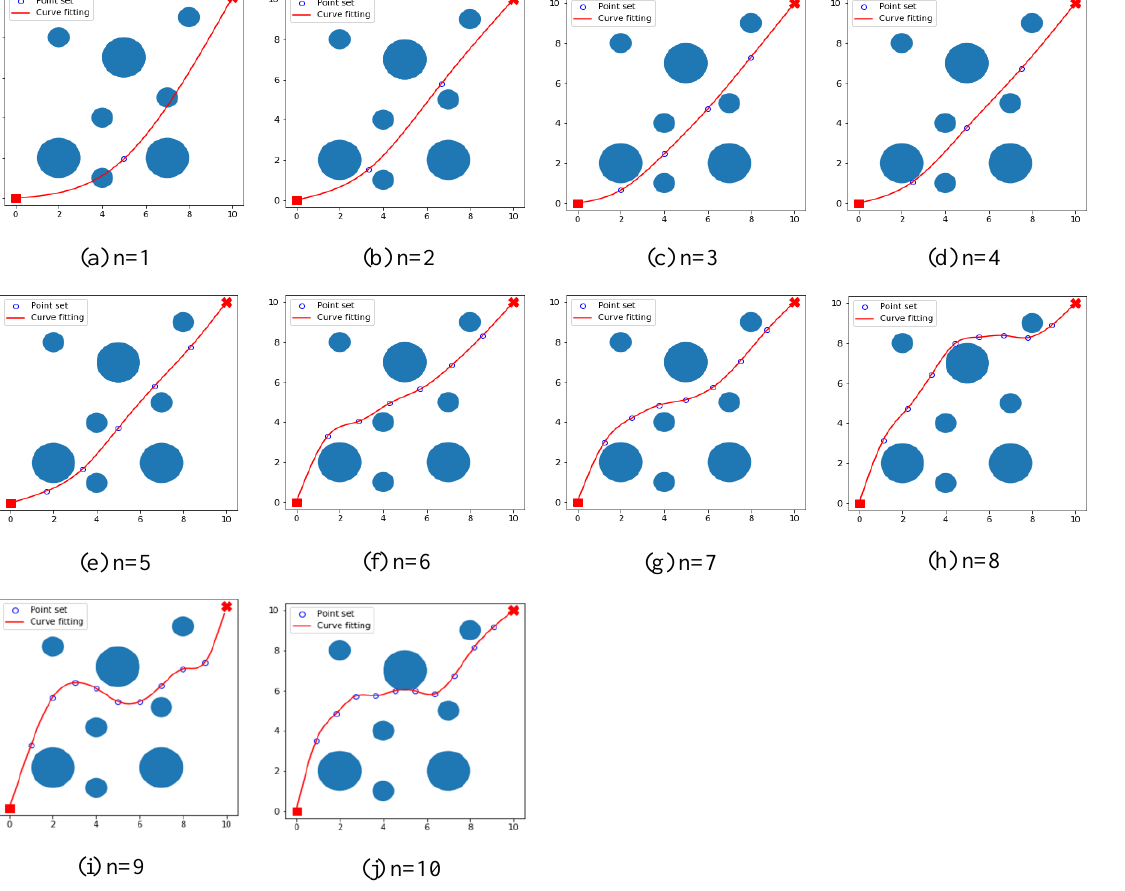
1820 Figure 8. Convergence curves of optimal fitness values based on IPSO-IDE with n (n = 1-10) path nodes under the environment 1. 6.2. Path Planning Experiment The path planning experiments are conducted based on IPSO-IDE in different envi- ronments, and the results are compared with other algorithms. In the experiments, the parameters of the Table 4 are used to test. Table 4. Parameter settings of the different test algorithms (meaning of the symbols are provided in the respective literatures. 1012 14 16